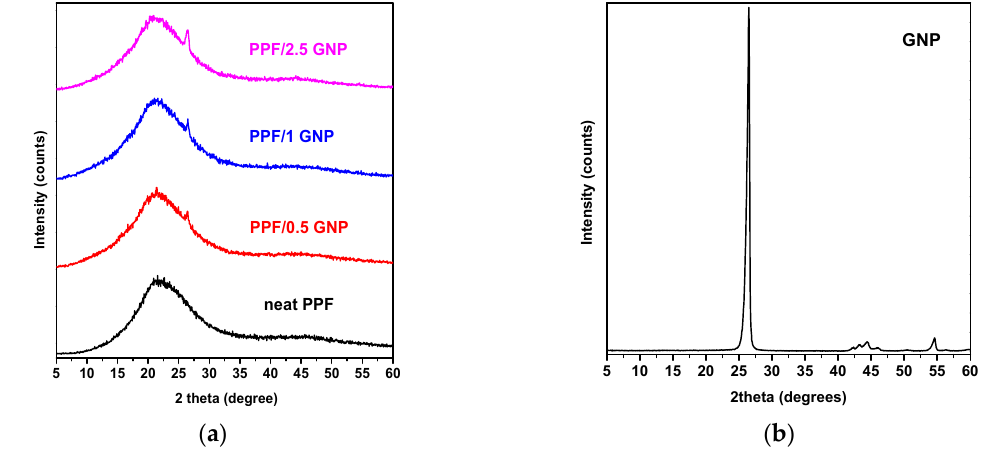
Figure 2. X-ray diffraction patterns of ( a ) PPF/GNP nanocomposites; ( b ) GNP.